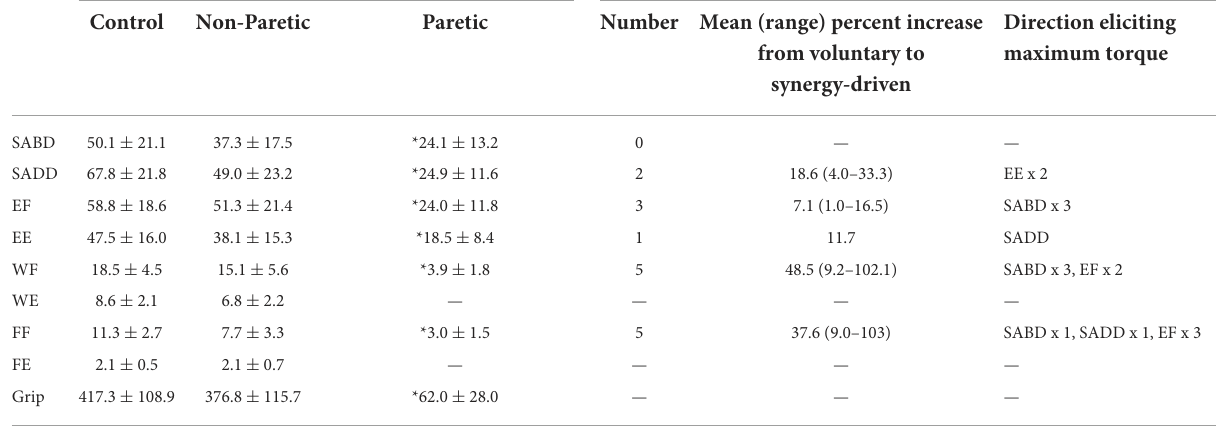
TABLE 2 Maximum voluntary strength measurements. Maximal voluntary strength in primary direction Participants in paretic group with synergy-driven strength Control Non-Paretic Paretic Number Mean (range) percent increase